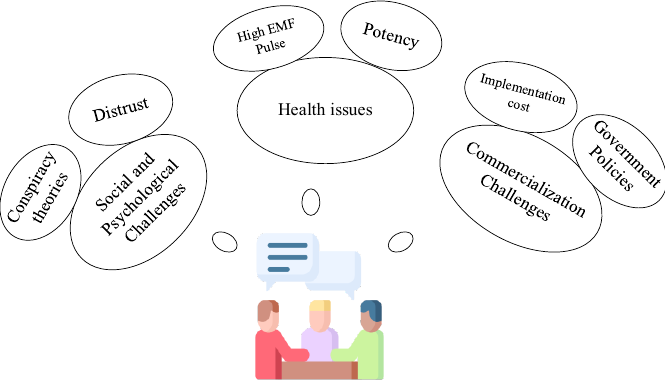
Figure 8. Non-wireless technology-related challenges for